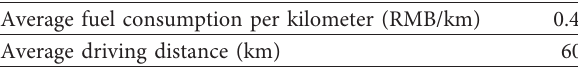
Table 3: Average fuel consumption and driving distance of taxis in an airport of a city.